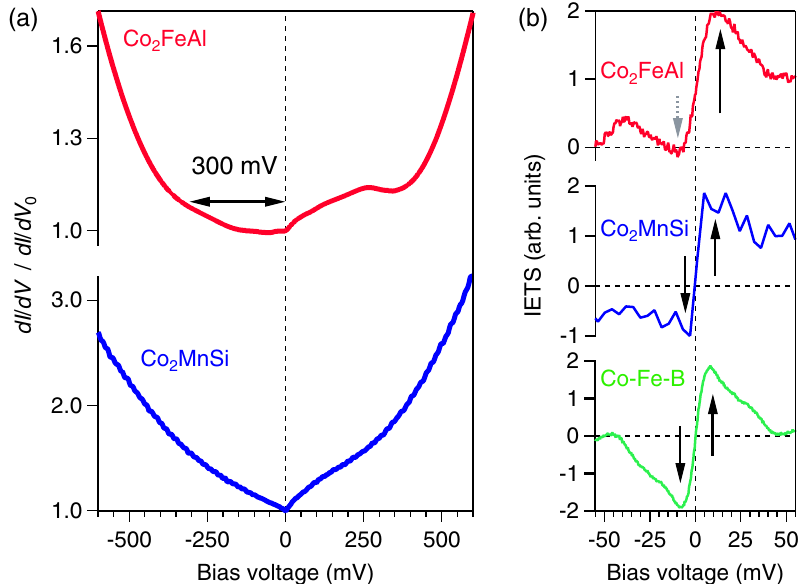
FIG. 4. Probing the electronic structure. (a) Tunneling spectroscopy of Heusler-based magnetic tunnel junctions. A gaplike feature of FeAl spectrum. (b) Inelastic electron-tunneling spectra of the Heusler-based and the reference Co-Fe-B 300 mV is visible in the Co 2 FeAl , the magnon peak at negative bias is suppressed (compare Ref. [42]). junctions. In Co 2